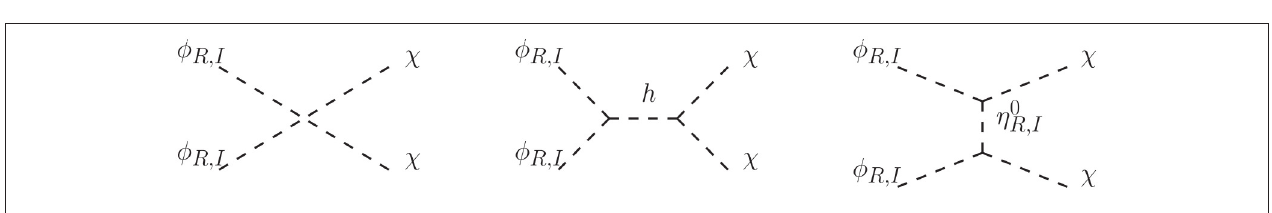
FIGURE 4 | The diagrams for the DM conversion processes.